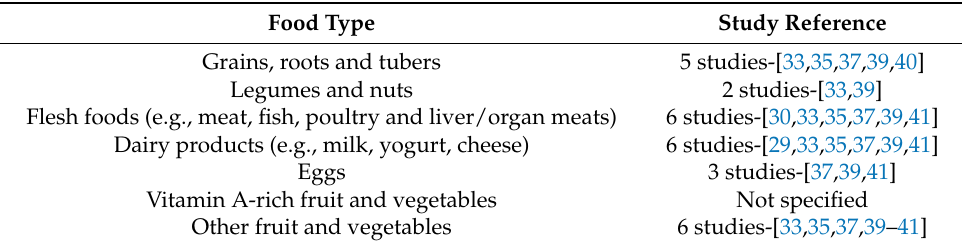
Table 3. Foods utilised for CF categorised into World Health Organisation (WHO) food groups. Food